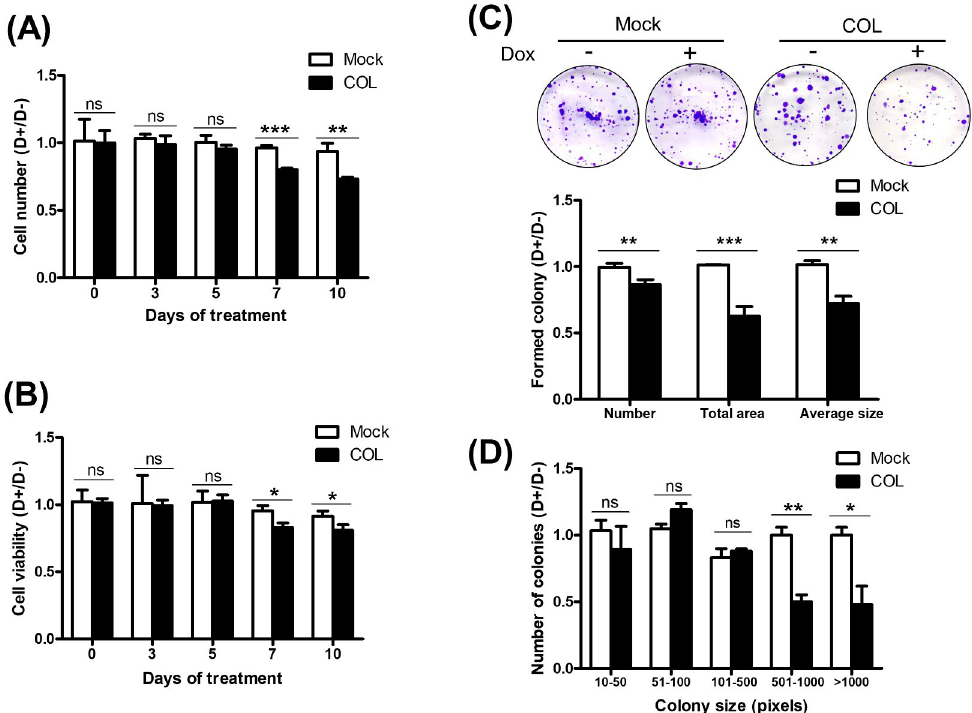
Fig 2. COL17 inhibits the cell proliferation, clonogenicity and growth in 2D culture. (A–B) MCF7/COL (COL) and mock cells were grown in 96-well plate for 48 hours and then treated with 0.1 μ g/ml of doxycycline (Dox, D+) or not treated (D − ). Cell numbers and cell viability were observed before and at 3, 5, 7 and 10 days of Dox treatment ( n = 5 biological replicates). The results of D+ were normalized to those of D − groups. (A) The number of COL and mock cells were determined by cell counting. (B) Cell viability of COL and mock was determined by MTT assay. (C–D) The COL and mock cells were grown in 6-well plate and treated as A–B . The represented images of colony formation assay of COL and mock cells observed at 12 days of Dox treatment. The images of cell colonies were analyzed by ImageJ program. Number of colonies, total area, and average size of colonies of D+ were normalized with those of D − groups ( n = 3 biological replicates). Two-tailed Student’s t -test; � P < 0.05, �� P < 0.01, ��� P < 0.0001; ns, P �